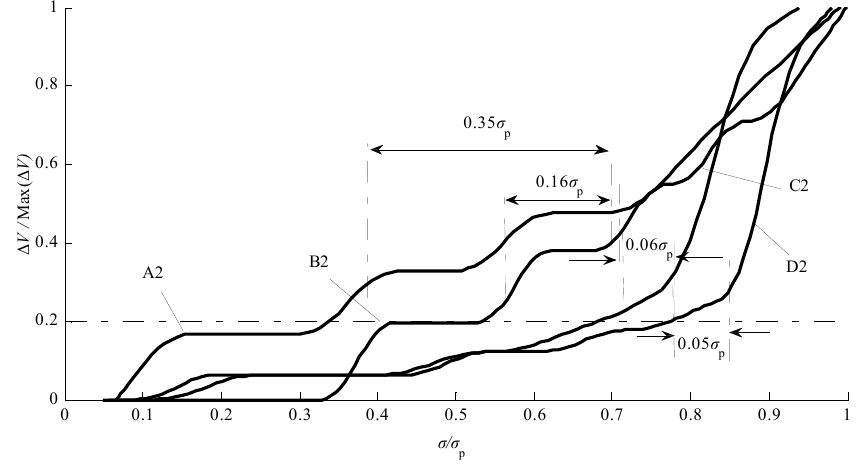
Figure 7. Change of wave velocity during the destruction of specimens with different moisture contents.